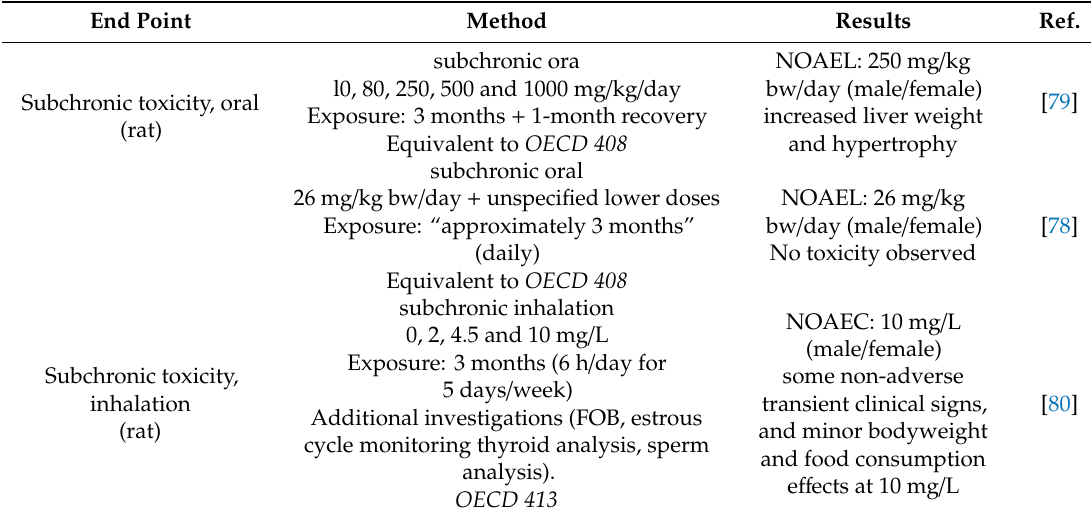
Table 6. Summary of the subchronic toxicity, oral and